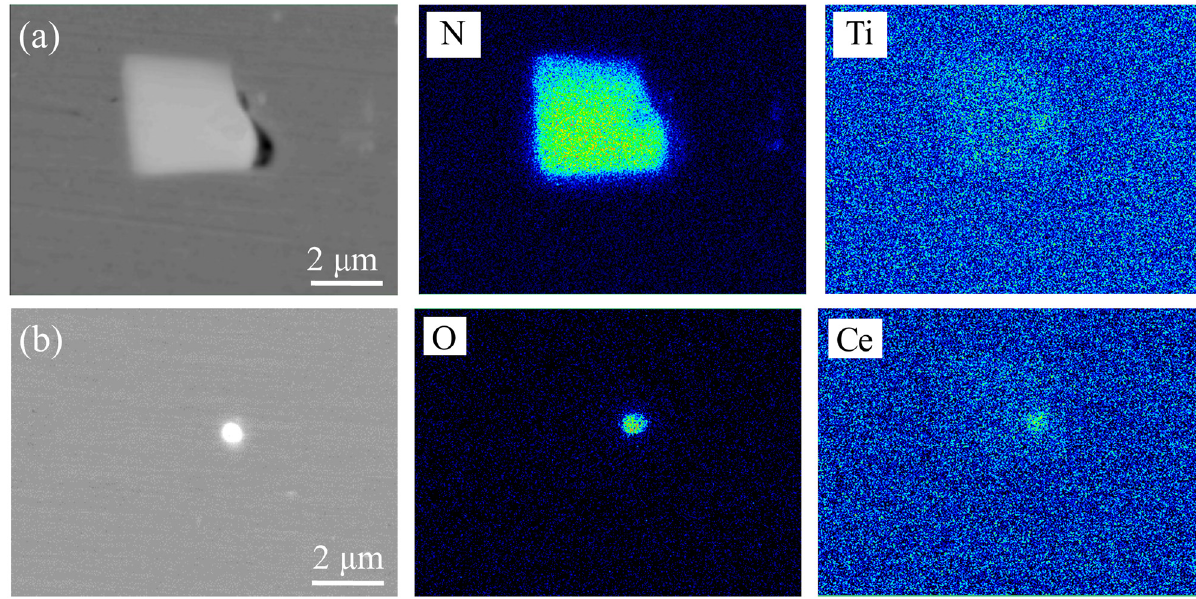
Figure 10: Images of pit morphologies in FSS2 after potentiostatic polarization in 10% NaCl solution. ( a ) Ce oxide; ( b )